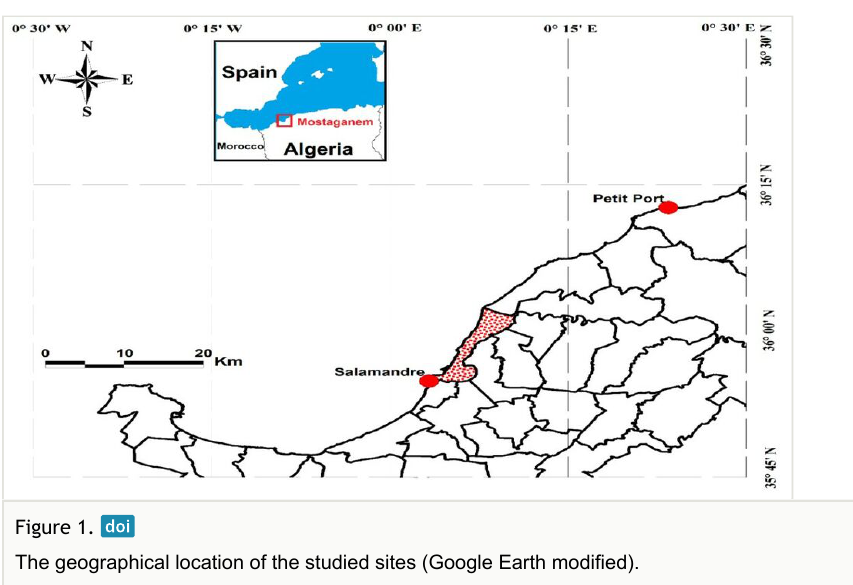
The geographical location of the studied sites (Google Earth